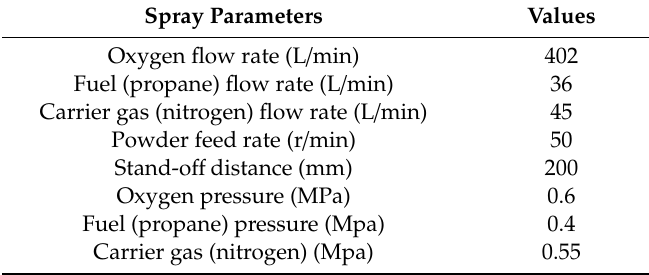
Table 2. The spray parameters of high-velocity oxygen fuel (HVOF) sprayed coatings.